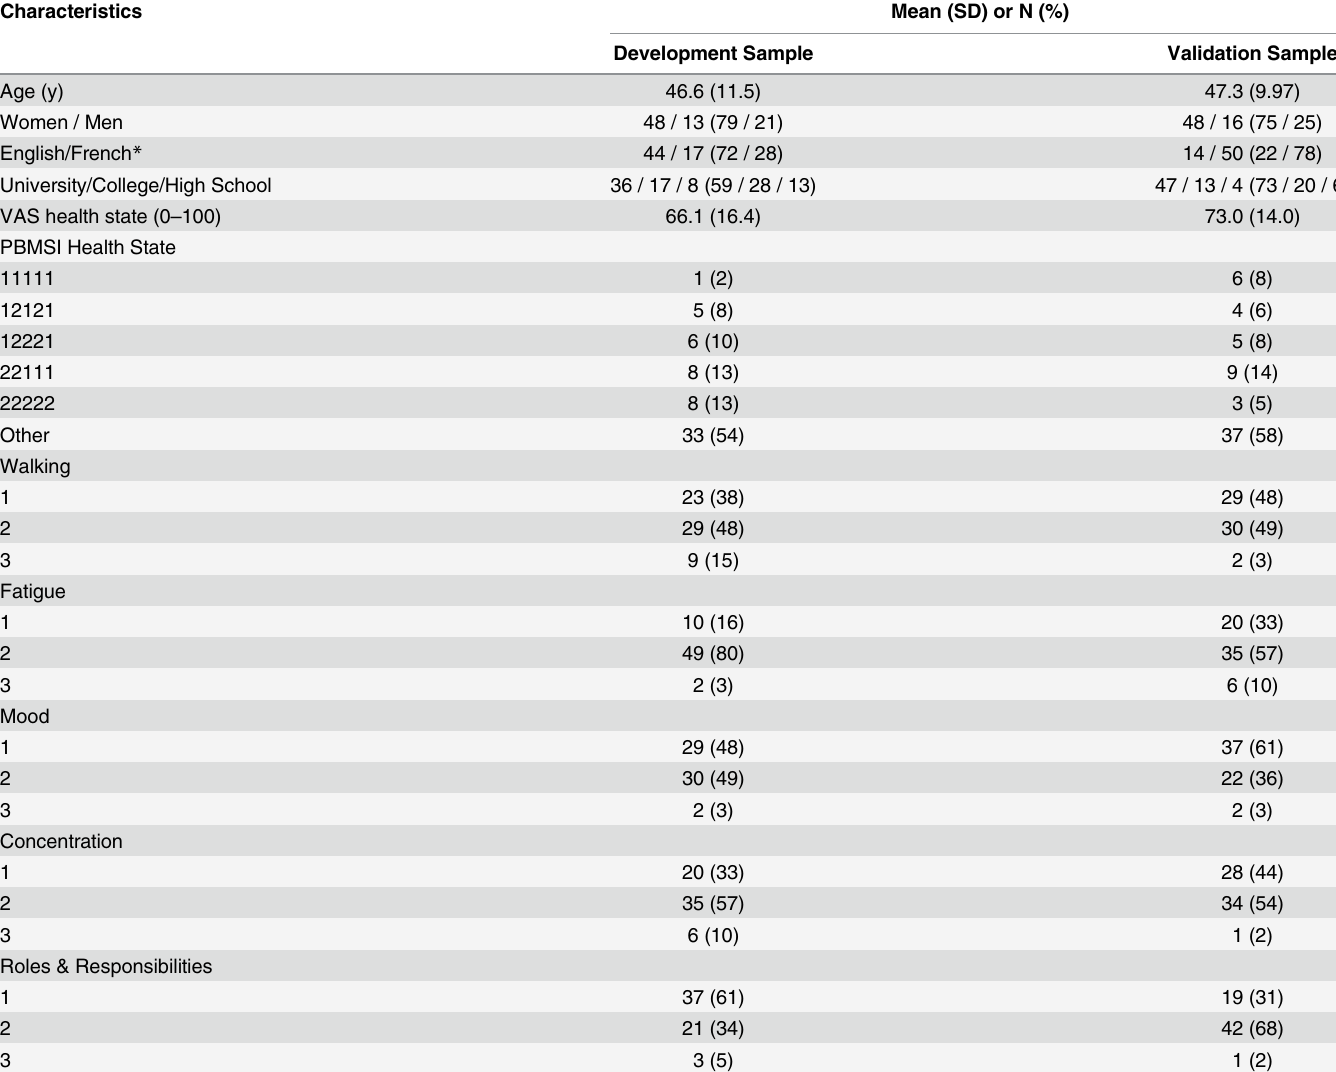
Table 2. Demographic and clinical characteristics of the Development and the Validation